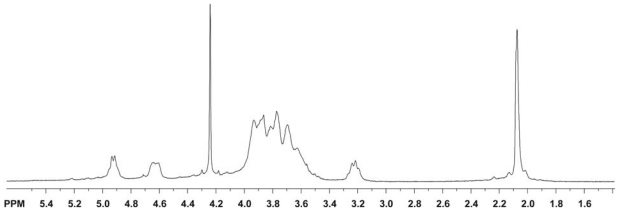
1H NMR spectrum of chitosan; the DA = 48. Spectrum was recorded at 400 MHz and 80 °C in D2O (pD ~ 5) relative to internal acetone (δH 2.225).